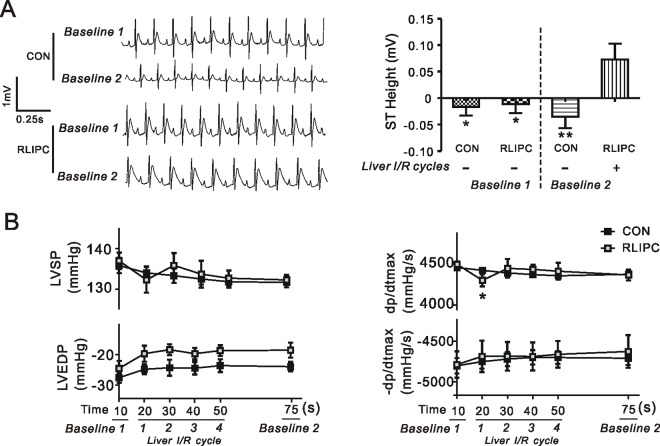
RLIPC elevates ST segment prior to induction of cardiac ischemia in rat model of arrhythmia.A) Left, typical ECGs from CON and RLIPC rats during baseline periods showing elevated ST segment in RLIPC-treated rats. Right, quantification of parameters from ECGs showing elevated ST segment in RLIPC rats post liver I/R stimulus (n = 9–10, each group). *P<0.05, **P<0.01, vs. RLIPC in the presence of liver I/R cycles. B) Variables recorded during the experimental protocol investigating the effect of liver I/R stimulus on hemodynamics prior to coronary artery ligation. LVSP, left ventricular systolic pressure; LVEDP, left ventricular end-diastolic pressure; ±dP/dtmax, maximum rate of increase/decrease in left ventricular pressure. Data are the mean±SEM (n = 6–7 in each group). *P<0.05 compared with values at Baseline 1. Baseline 1 indicates the first baseline value after 10 minutes stabilization; Baseline 2 indicates the second baseline value obtained 5 minutes prior to coronary ligation. Hearts in RLIPC group experienced four cycles of I/R stimulus, indicated as 1, 2, 3, 4.